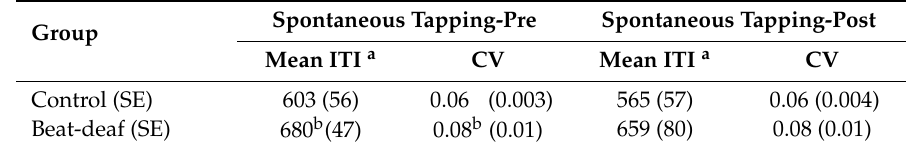
Table 5. Mean inter-tap interval (ITI) and coe ffi cient of variation (CV) of spontaneous tapping. Spontaneous Tapping-Pre Spontaneous Tapping-Post Group Mean ITI a CV Mean ITI a